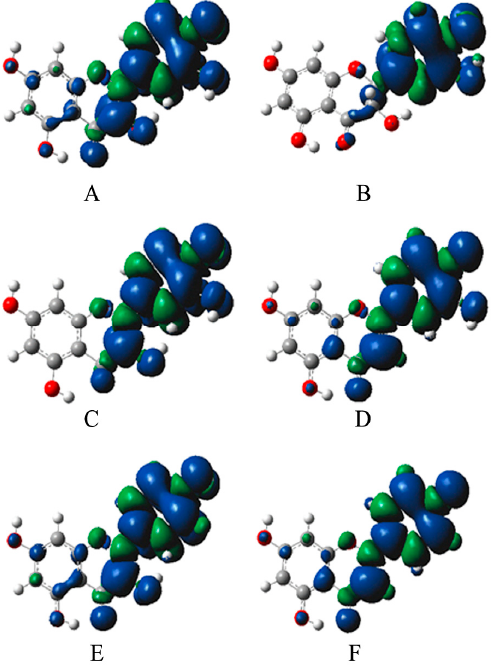
Figure 3. The 4 ′ -radical spin density sketch map of six flavonoid aglycones. ( A ) Quercetin; ( B ) Taxifolin; ( C ) Catechin (4 ′ -radical); ( D ) Luteolin; ( E ) Kaempferol; ( F ) Apigenin.